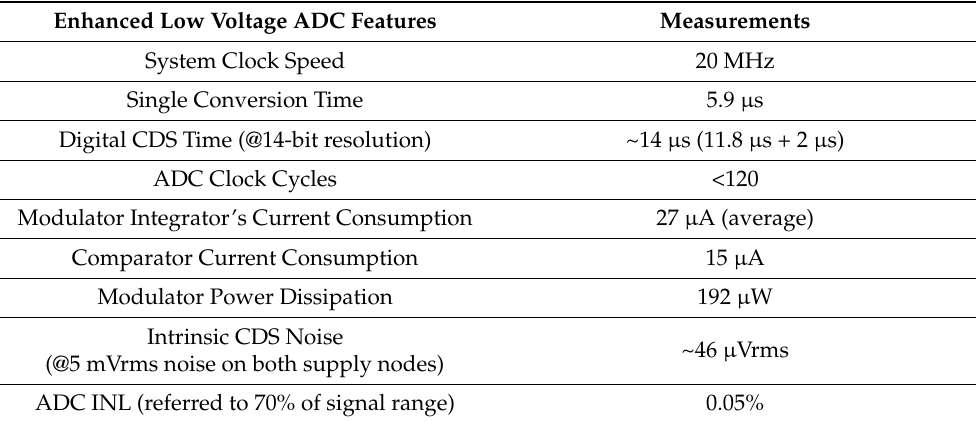
Table 1. Summary of key ADC features.